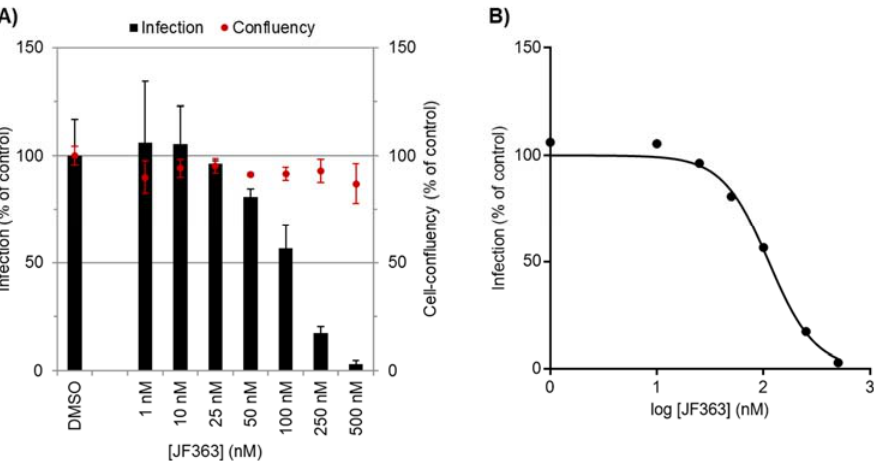
Figure 1. The dose-dependent activity of JF363 against P. berghei hepatic infection in vitro. ( A ) Total parasite load (infection scale, bars) and cell viability (cell confluency, dots). Results were normalized to the negative control, the drug vehicle DMSO, and are represented as mean ± SD. ( B ) Dose–response curve. A representative experiment out of independent 3 biological replicates.